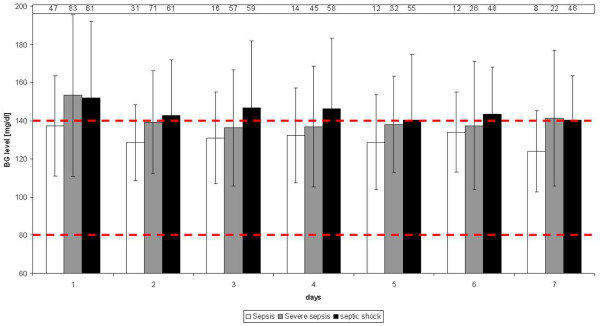
Mean blood glucose (BG) level per day over time for the different sepsis subgroups. Each column represents the mean BG level of all patients during sepsis. The different levels of sepsis are grouped for each of the first seven days. The number above each error bar indicates the number of patients.